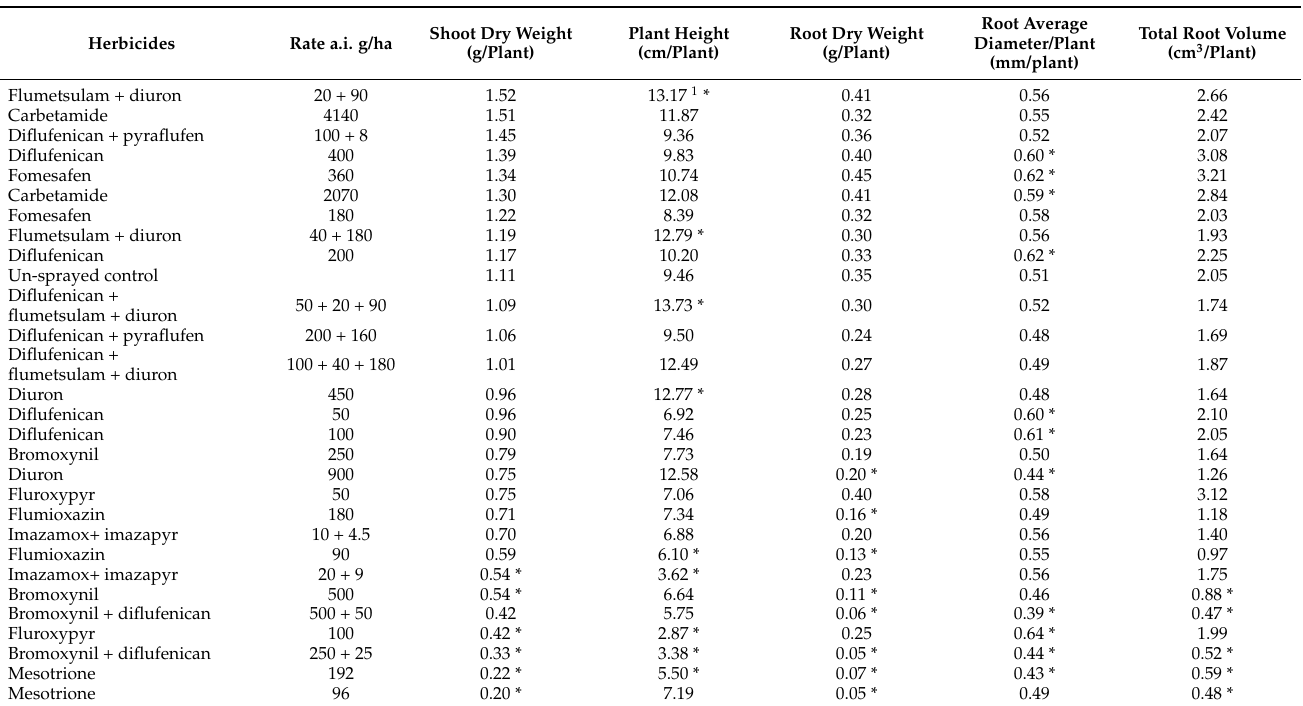
Table 12. Effect of post-emergent herbicides on tedera shoot dry weight, plant height, root dry weight, root average diameter, and total root volume in a pot experiment at Northam in 2020.